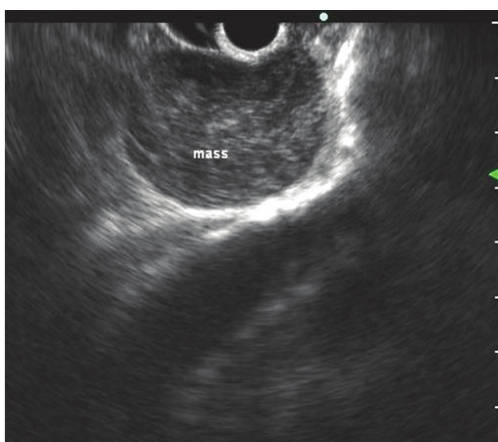
Figure 1: Endoscopic ultrasonography showing a hypoechoic mass with a slightly heterogeneous internal echo and regular margins located just below the gastroesophageal junction.